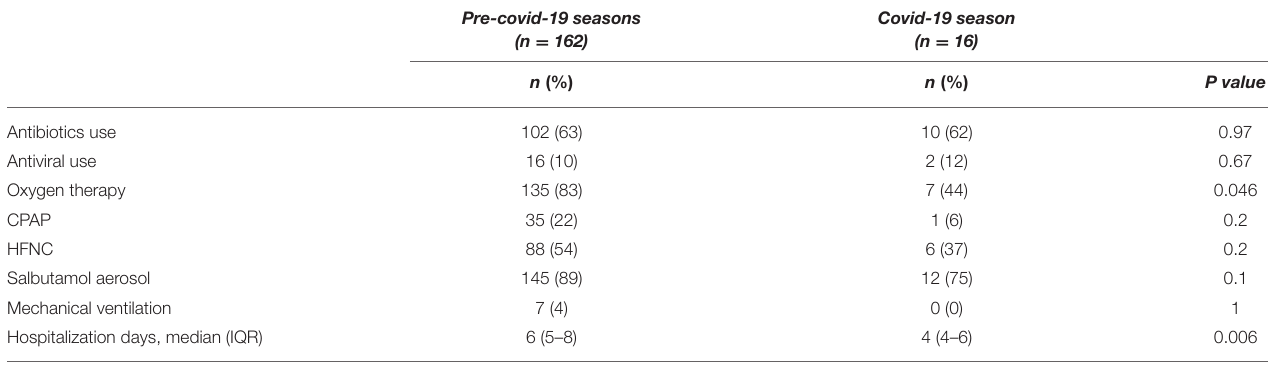
TABLE 4 | Therapies and outcomes in pre-Covid seasons and 2020/2021